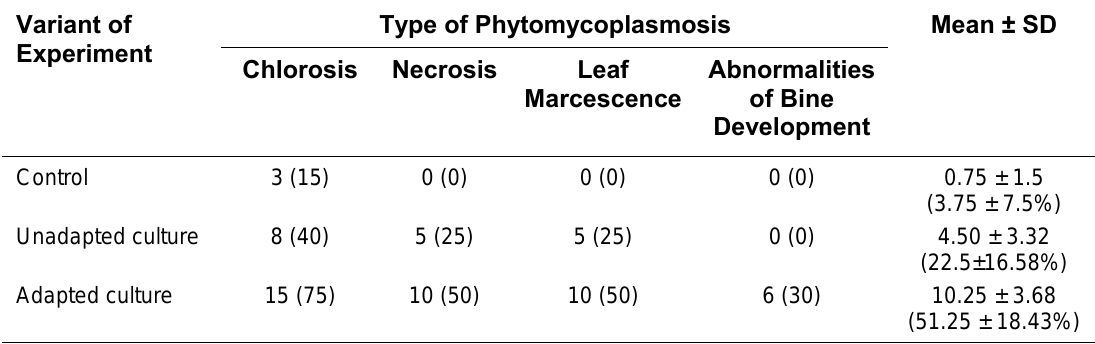
A Number of V. minor L. Plants with Various Morphological Deviations in Control and Experimental Groups* Type of Phytomycoplasmosis Variant of Experiment